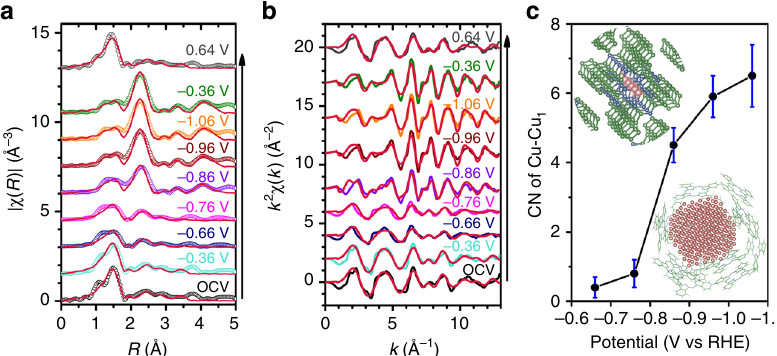
Fig. 4 Fitting results of the EXAFS spectra of the CuPc catalyst at different potentials in CO 2 -saturated 0.5 M aqueous KHCO 3 . Fitted a R-space and b k- space EXAFS spectra (red traces) of the CuPc catalyst. The experimental data are also plotted for comparison. c First-shell Cu – Cu CNs of the CuPc catalyst at different potentials. The upper left inset shows the CuPc crystal structure, and the lower right inset illustrates a possible con fi guration of the Cu nanoclusters generated under the electrocatalytic conditions. Color key: green — C; blue — N; pink — Cu. Error bars represent the uncertainty of CN determination from the EXAFS